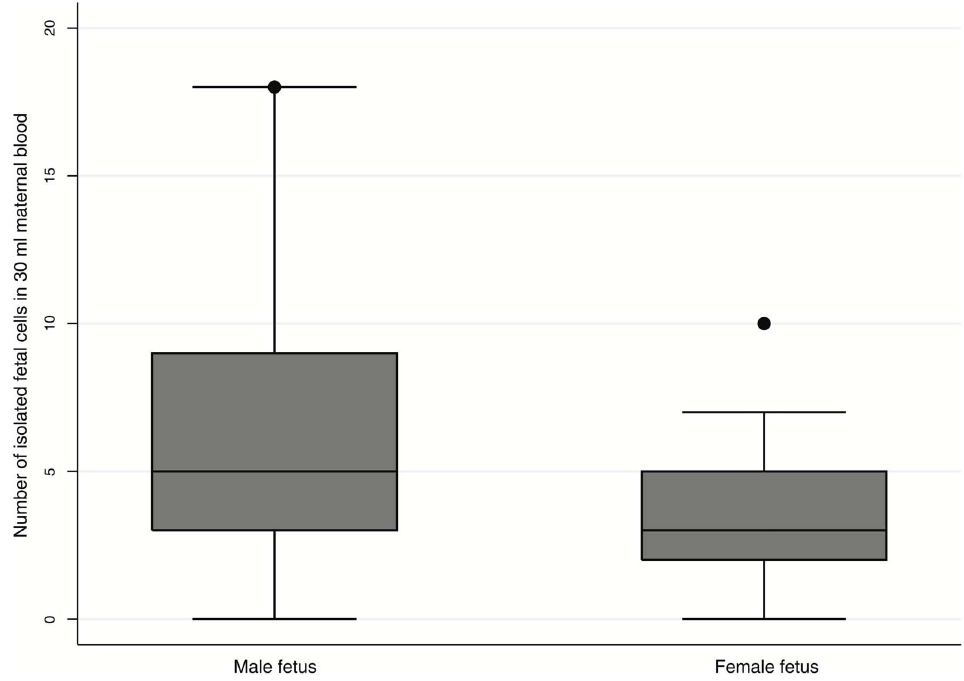
Figure 2. The number of isolated fetal cells in 30 ml of blood among 29 pregnant women with male fetuses and 28 women with female fetuses; p= 0.04 (Mann-Whitney-Wilcoxon).